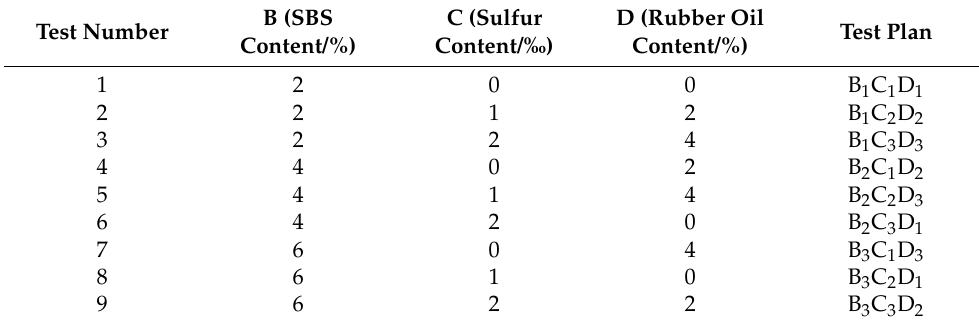
Table 4. Orthogonal test plan.